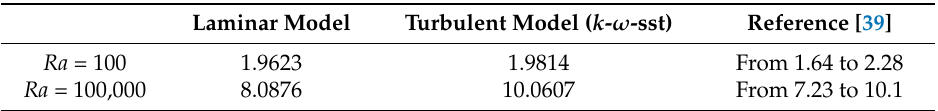
Table 2. Average Nusselt numbers for Ra = 100 and 10 5